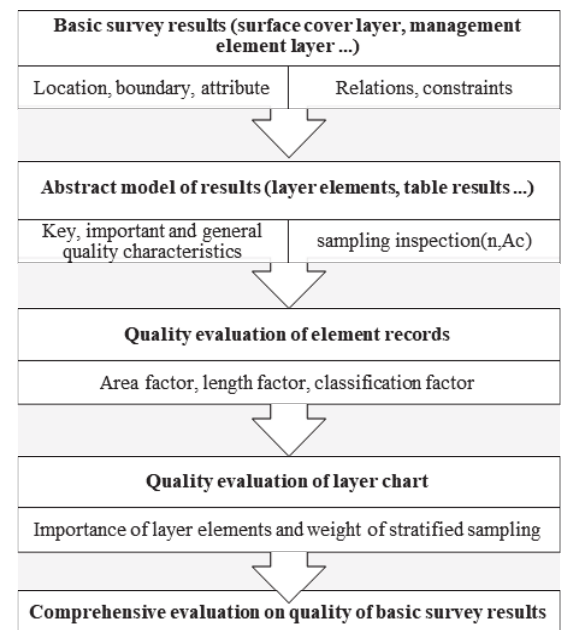
Figure 2. Quality Evaluation and Assessment of Basic Survey